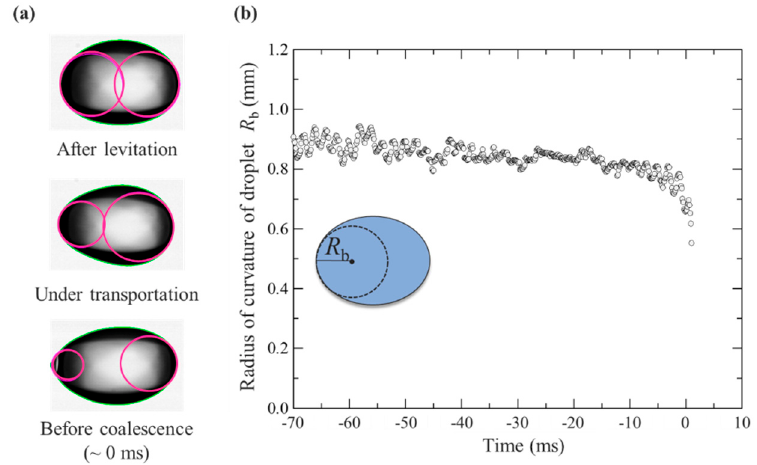
Figure 3. Quantification of droplet motion before the coalescence shown in Figure 2c: ( a ) Image processing of droplet interface. ( b ) Time evolution of the radii of curvature of droplets (left edge) from levitation to coalescence. The inset represents the schematic description of the radius of curvature of a droplet.